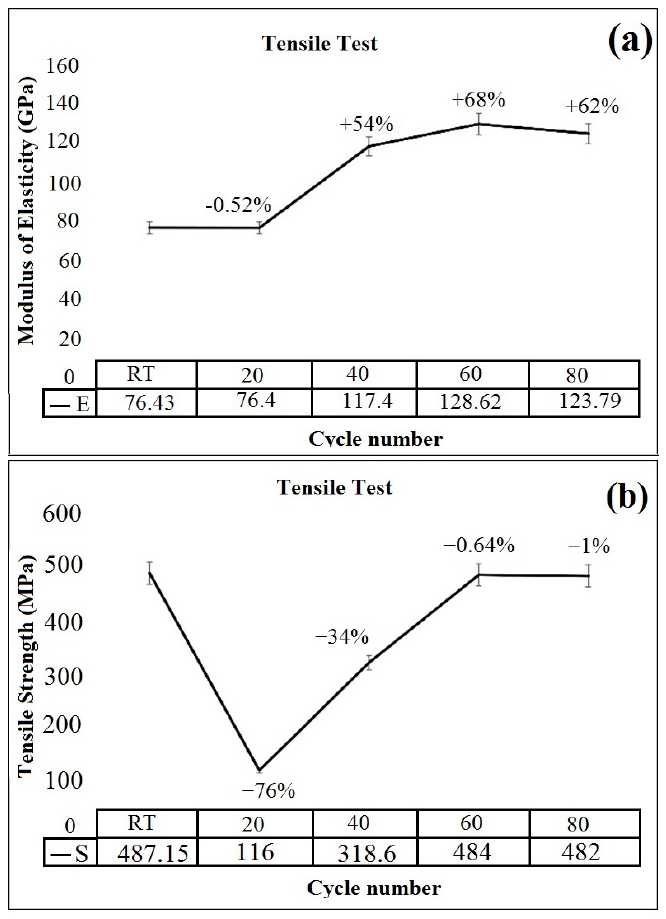
Figure 7. Tensile test results of room temperature (RT) and thermal exposure CFRP composites, ( a ) modulus of elasticity, ( b ) tensile strength. ( a ) modulus of elasticity, ( b ) tensile